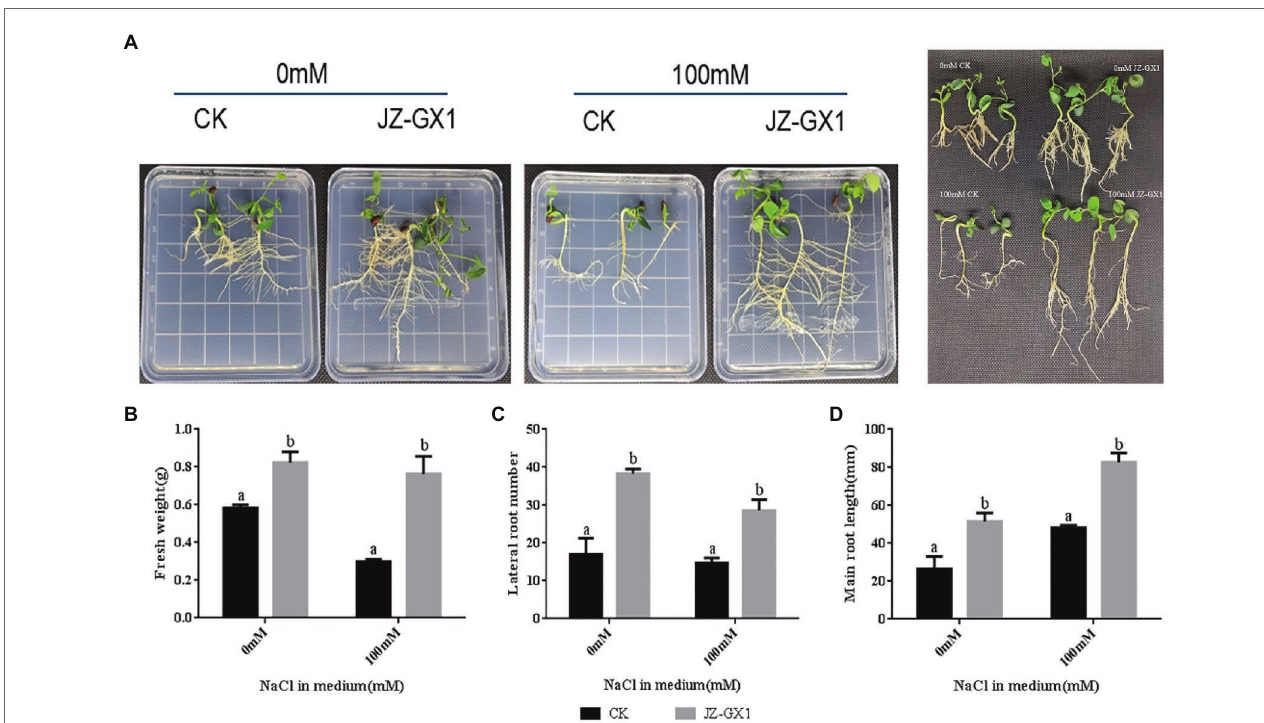
FIGURE 1 | Effect of Rahnella aquatilis JZ-GX1 on the growth of Robinia pseudoacacia . (A) phenotype; (B) fresh weight; (C) lateral root number; (D) primary root length. Different letters indicate significant differences between treatments ( p < 0.05), and the same applies